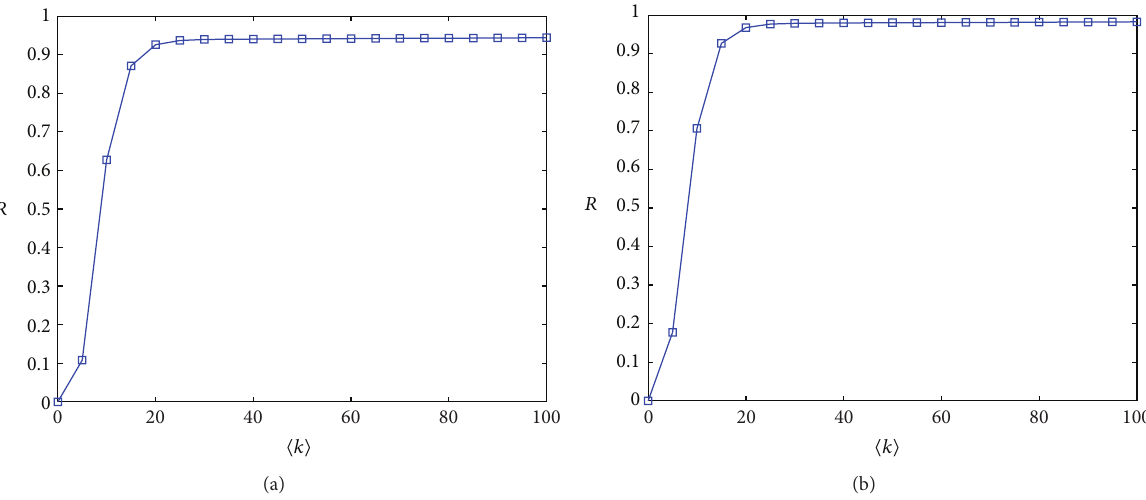
Figure 9: Density of stiflers on regular networks and random